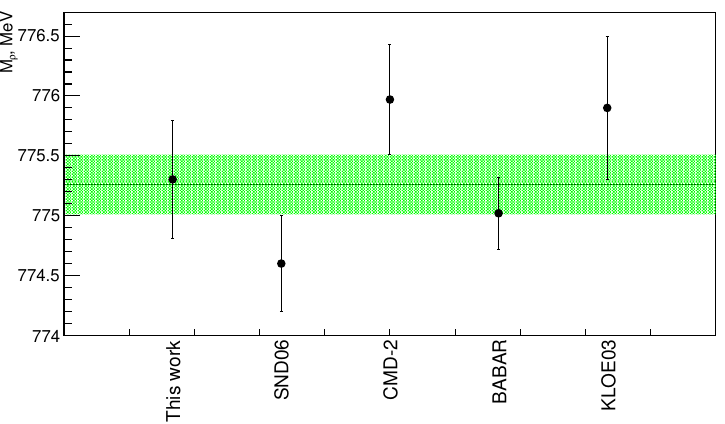
Figure 17 . The (cid:26) meson mass m (cid:26) measured in this work and in refs. [26, 28, 32, 51]. The shaded area shows the PDG value [46].